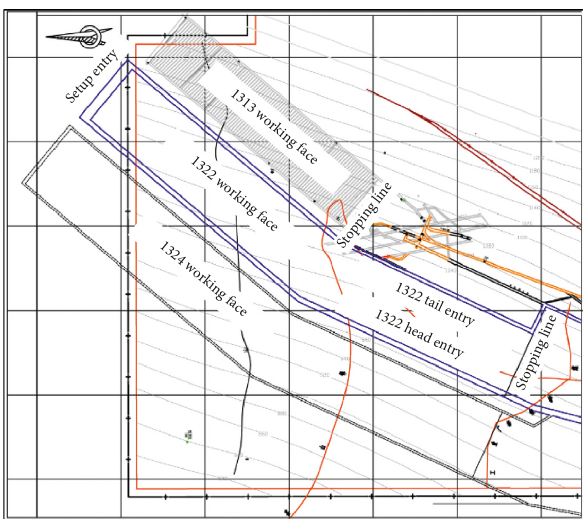
Figure 2: Overview of the 1322 working face at Jindi Coal